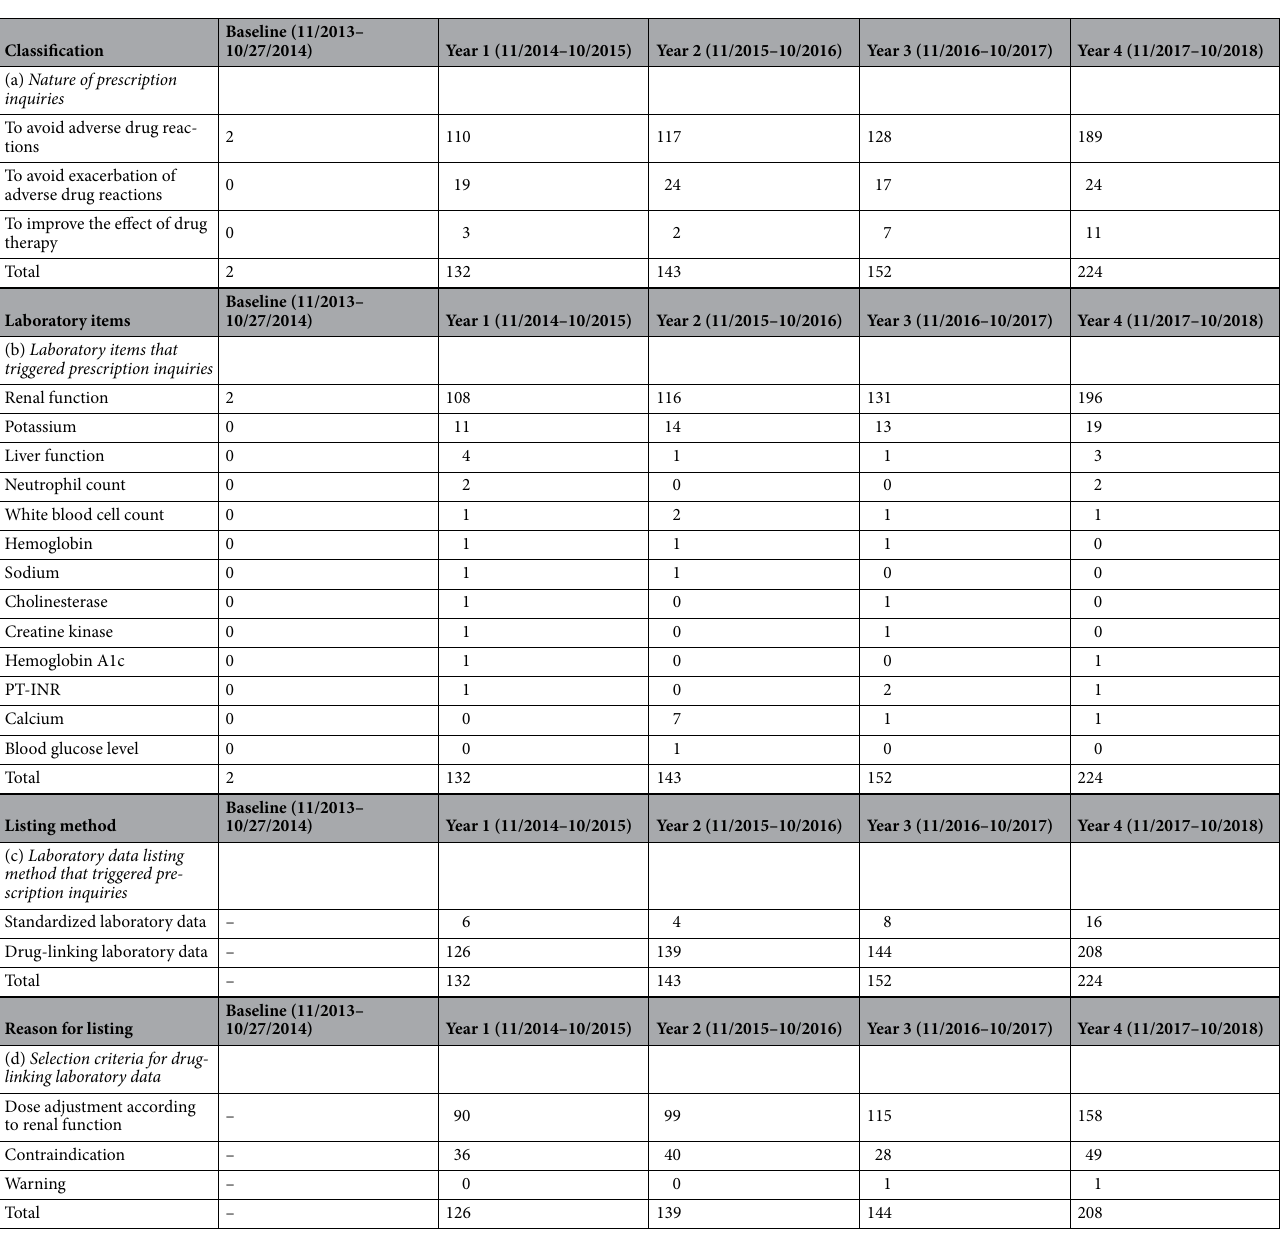
Table 3. Analysis of prescription changes due to prescription inquiries related to laboratory